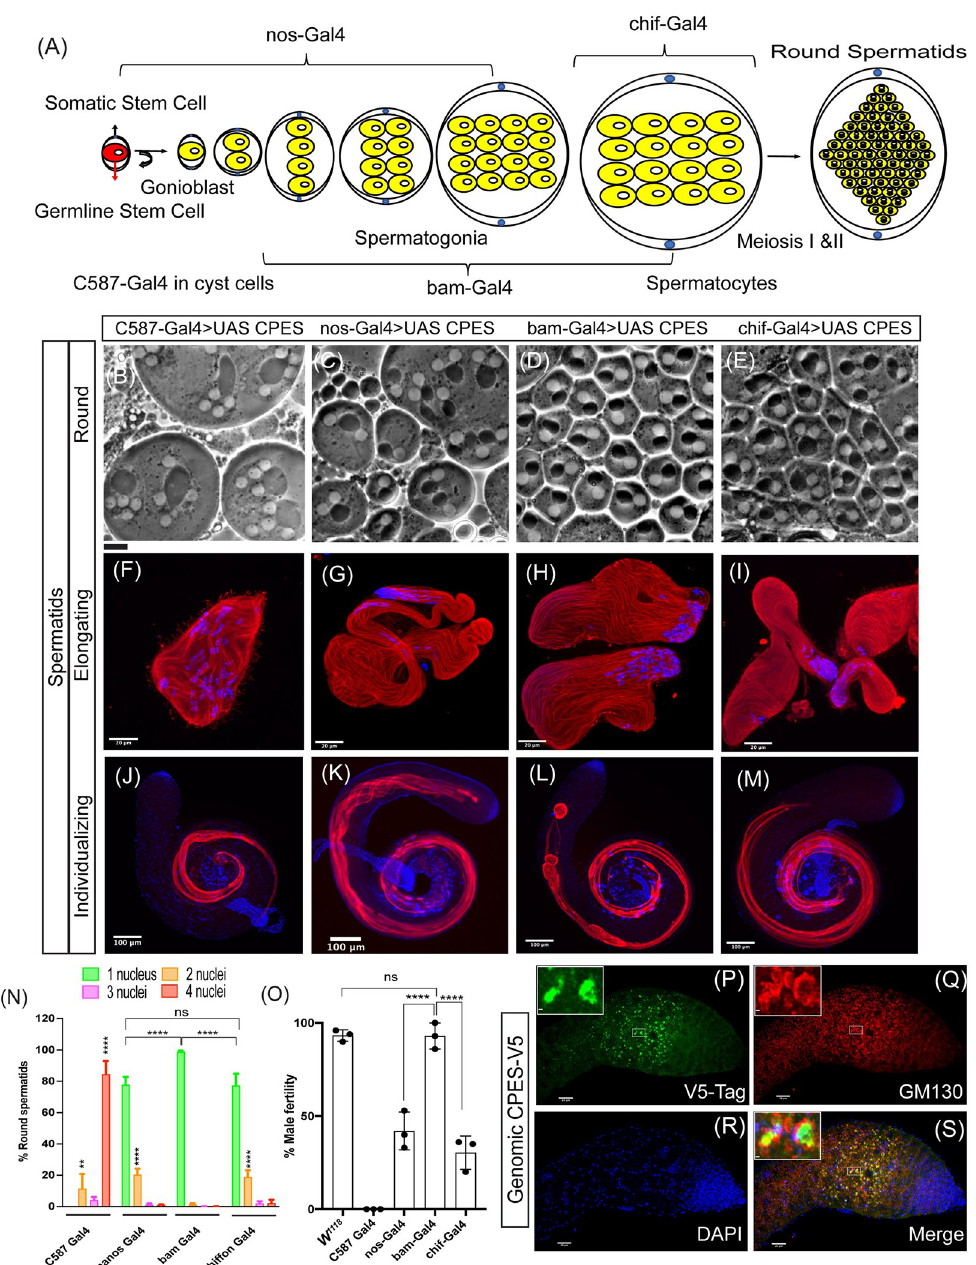
Fig 3. Genetic dissection of spatiotemporal role of CPES in spermatogenesis. (A) Schematic illustration of early germ cell differentiation and stage-specific Gal4 expression patterns. (B–E) Phase contrast microscopy of round spermatids in live testis squash preparations. (F–I) Early elongating spermatids immunostained for beta tubulin primary antibody (red) and DAPI for DNA (blue). (J–M) Individualizing spermatids immunostained for cleaved caspase DCP-1 antibody (red) and DAPI for DNA (blue). (B, F, and J) C587-Gal4 drives the expression of UAS-CPES in cyst cells of cpes mutants. (C, G, and K) Nanos-Gal4 drives the expression of UAS-CPES in GSCs and spermatogonia. (D, H, and L) bam-Gal4 drives the expression of UAS-CPES in 4–16 cell stages of spermatogonia and spermatocytes. (E, I, and M) chif-Gal4 drives the expression of UAS-CPES in early spermatocytes. (N) Measurement of cytokinetic defects in testis squash preparations in cyst and germ cell-specific rescue samples. Round spermatid count from 4 independent experiments for C587-Gal4 > UAS-CPES ( n = 500), 6 independent experiments nos-Gal4 > UAS-CPES ( n = 2,500), 5 independent experiments for bam-Gal4 > UAS-CPES ( n = 2,500), and 6 independent experiments for chif-Gal4 > UAS-CPES ( n = 3,000). (O) Male fertility test where individual male from each of the UAS-CPES rescue experiment was crossed with 3 wild-type females. The vials that produced at least 5 pupae or progeny were counted as fertile and plotted as percent fertility compared